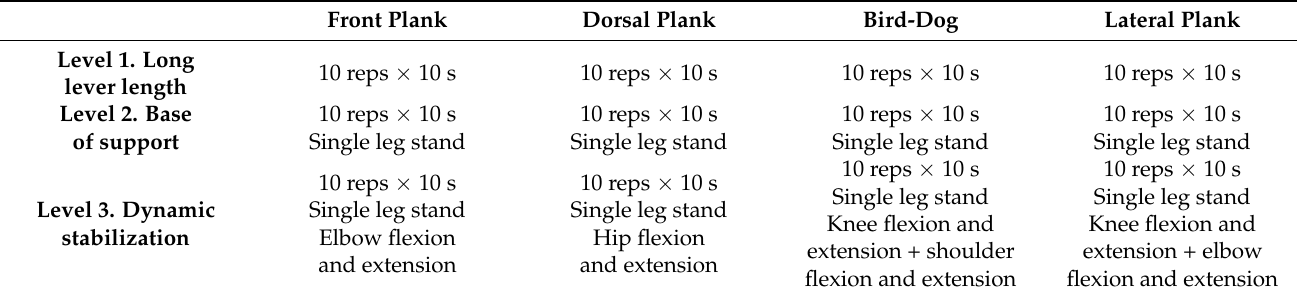
Table 10. Progression of the training tasks of the GCS group during the 8-week training